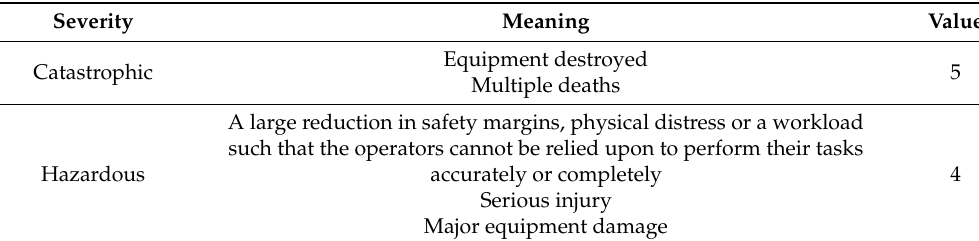
Table 3. Safety risk severity adaptable to RPAS [30].